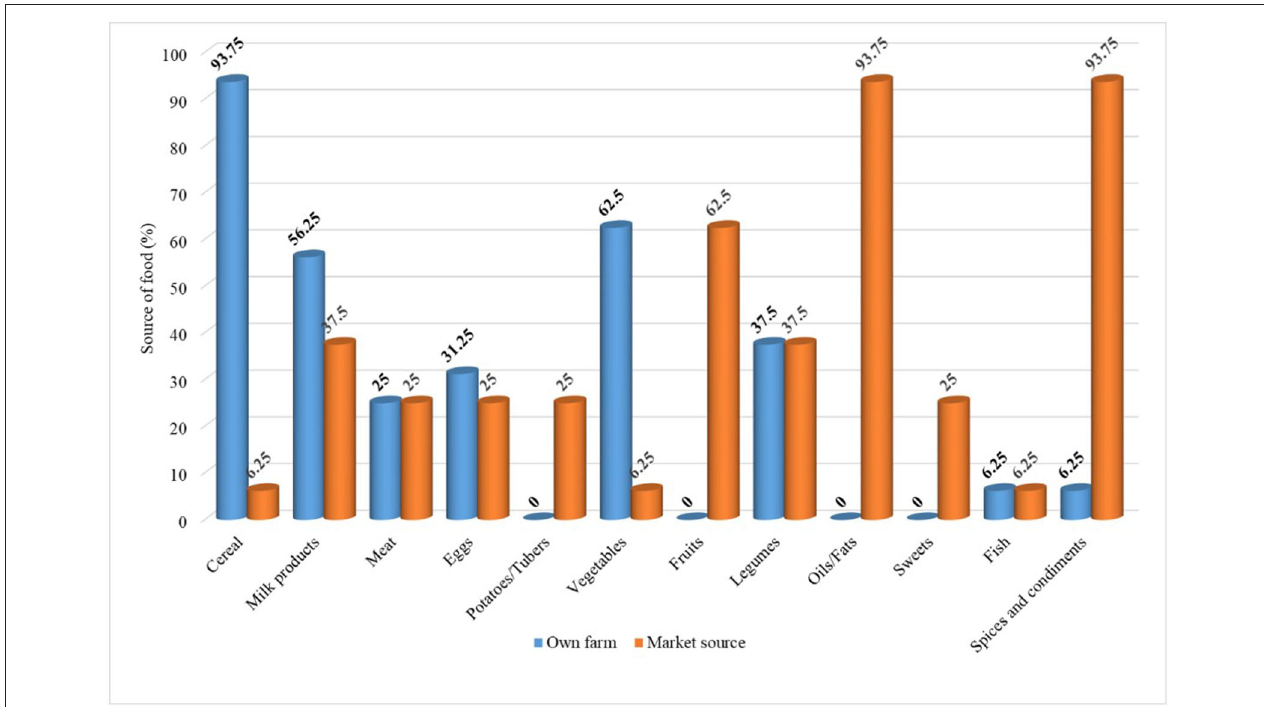
FIGURE 3 | Consumption of each food group sourced from own farms and or local markets among farm